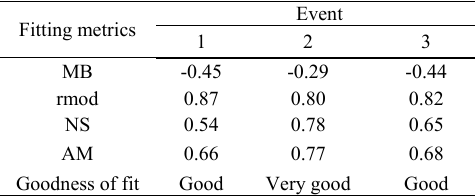
Table 5. Fitting measures for runoff simulation during calibration process